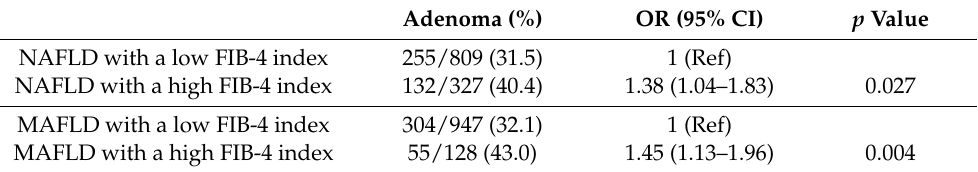
NAFLD, nonalcoholic fatty liver disease; OR, odds ratio; CI, confidence interval; FIB-4, Fibrosis-4 index. NAFLD: adjusted for sex, smoking, triglyceride level, HDL cholesterol level, diabetes, body mass index, hypertension, and visceral fat area. MAFLD: adjusted for sex, smoking, and visceral fat